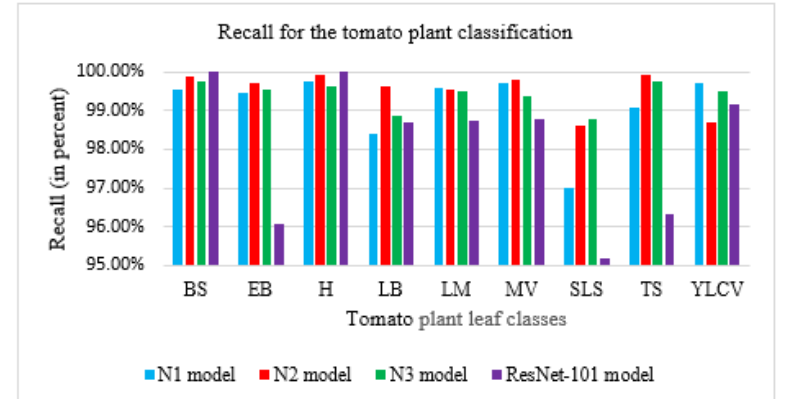
Figure 10. Recall performance for TPL